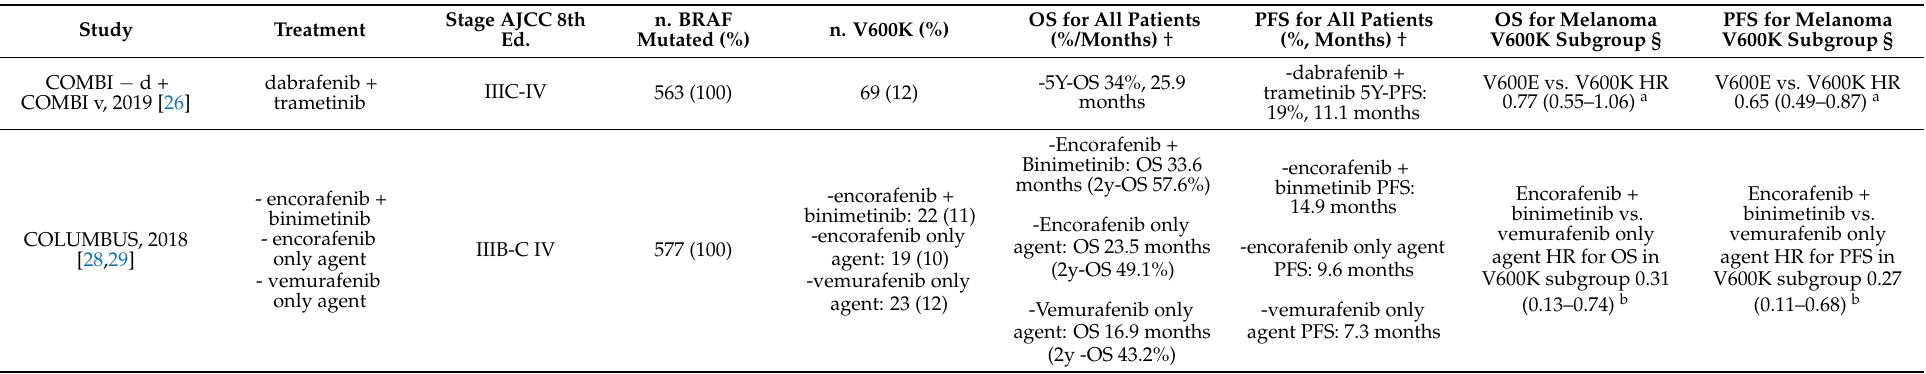
Table 2. Overall survival and progression free survival reported among the studies for melanoma patients and for melanoma V600K patients treated with BRAFi ± MEKi and/or immunotherapy (anti-PD/L-1 and/or